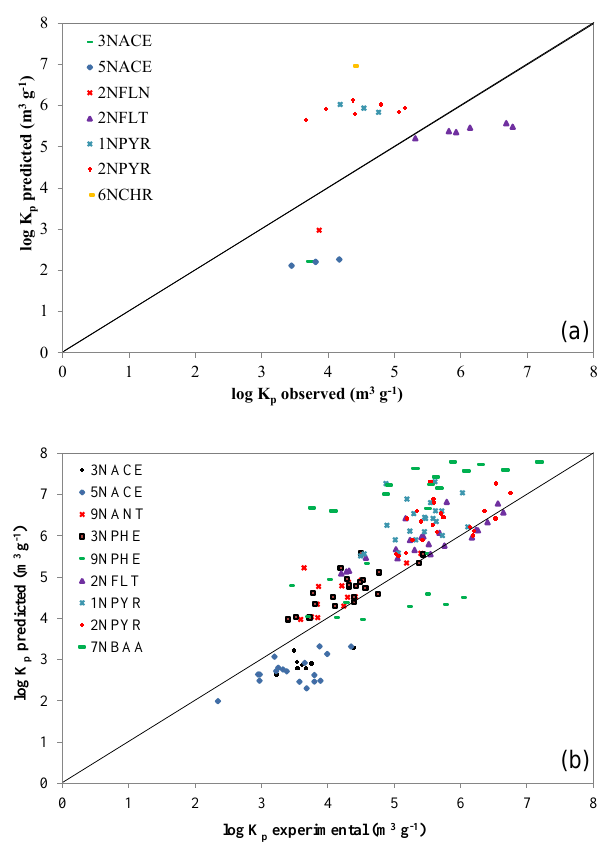
Figure 2. Predicted versus experimental log K p (m 3 airg − 1 PM) for NPAHs using the multi-phase ppLFER model at the (a) marine and (b) continental